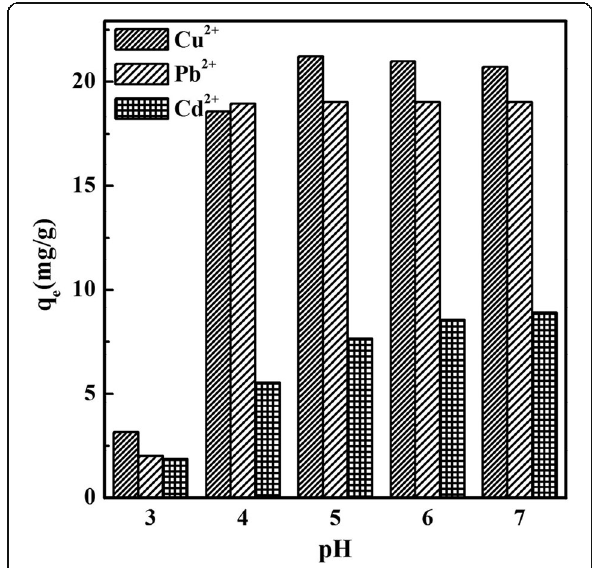
Fig. 4 The effect of pH on Cu 2+ , Pb 2+ , and Cd 2+ removal using